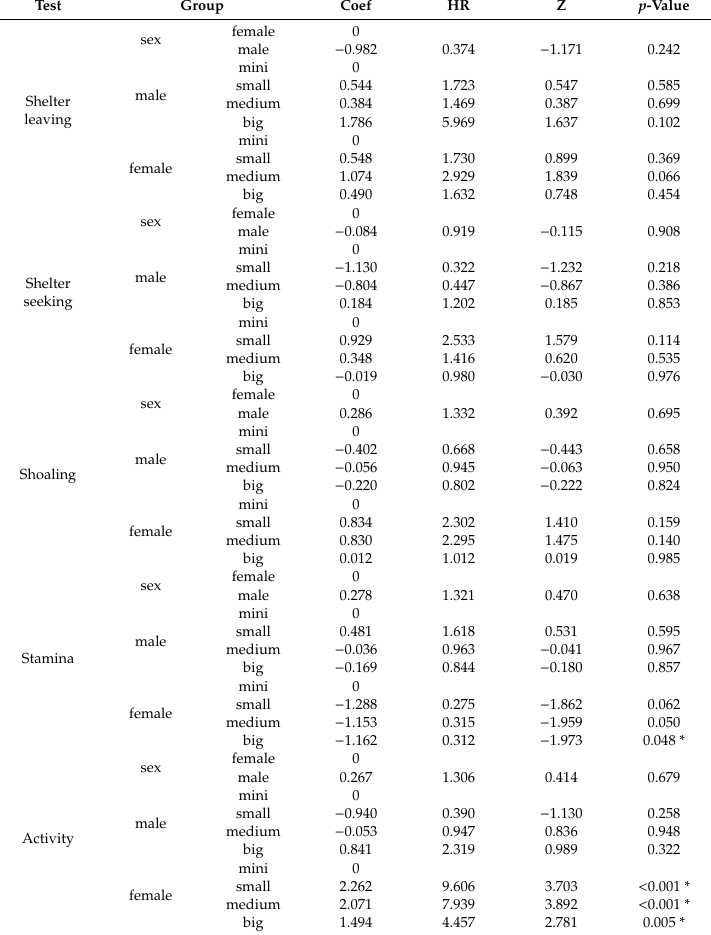
Table A2. E ff ects of group and sex on behavior as revealed by a Cox regression model. Group di ff erence was observed in activity pattern. Significant di ff erences were reported at * p < 0.05.